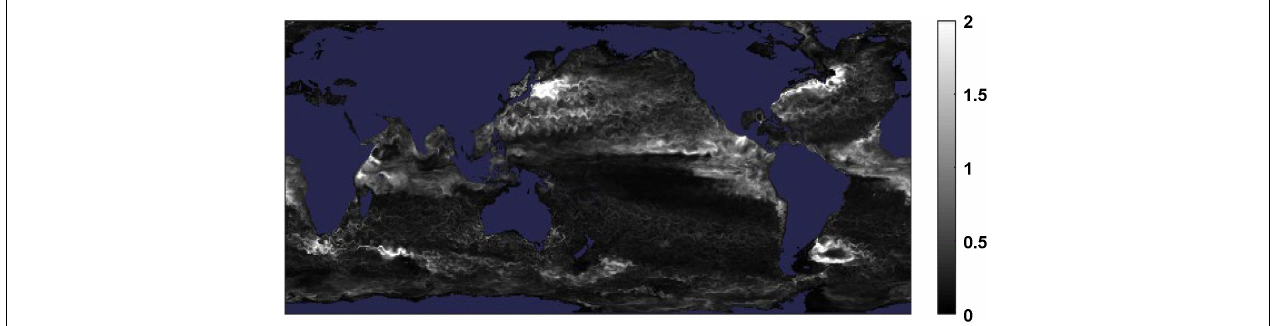
FIGURE 2 | Ensemble standard deviation of temperature ( ◦ C) at the model depth of 65 m. A daily snapshot from a 2 year hindcast using a 1/10 degree, 51 vertical level implementation of MOM4p1 and a 96-member ensemble Kalman Filter data assimilation of satellite altimetry, satellite SST and in situ profiles. The colorbar is in degrees C.